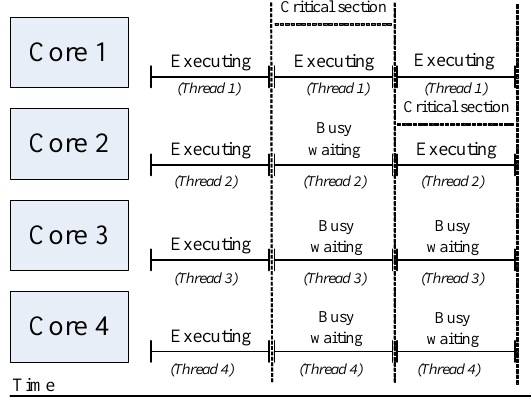
Figure 2. Power-saving opportunity of multi-core processors.